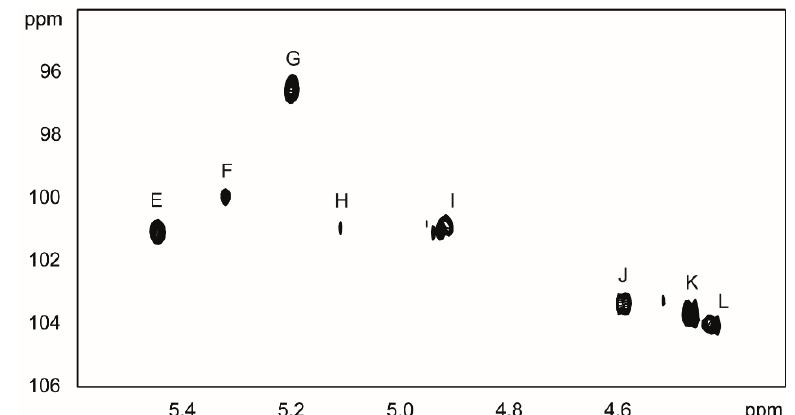
Figure 5. Portion of the HSQC spectrum showing the anomeric 1 H- and 13 C-NMR signals from the core oligosaccharide of P. shigelloides O24. The uppercase letters refer to designation of sugar residues.